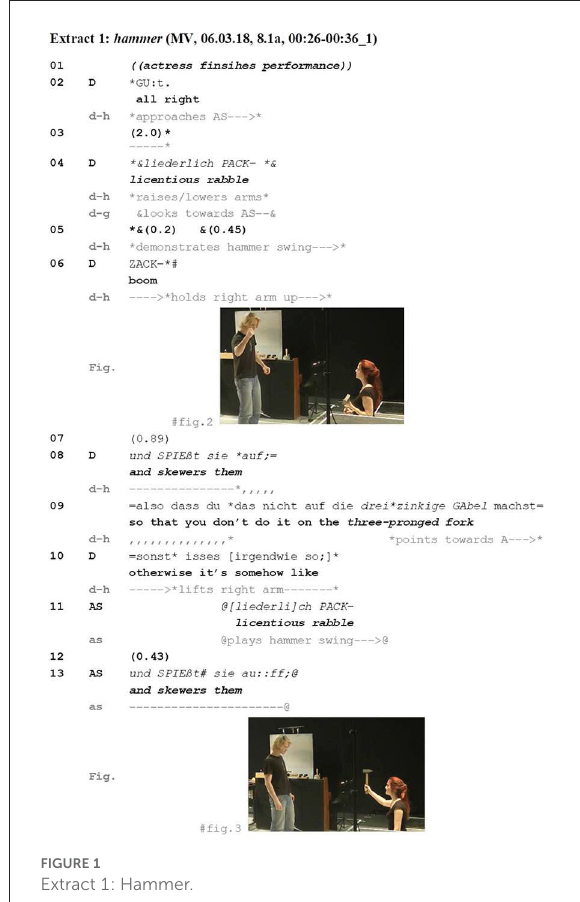
FIGURE1 Extract 1: Hammer.